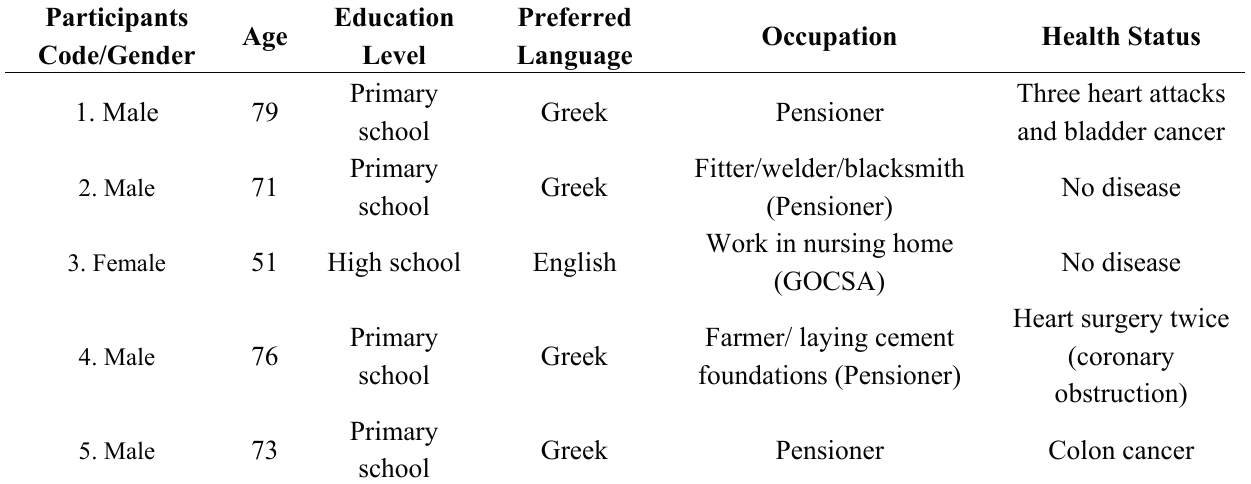
Table 1. Personal characteristics of